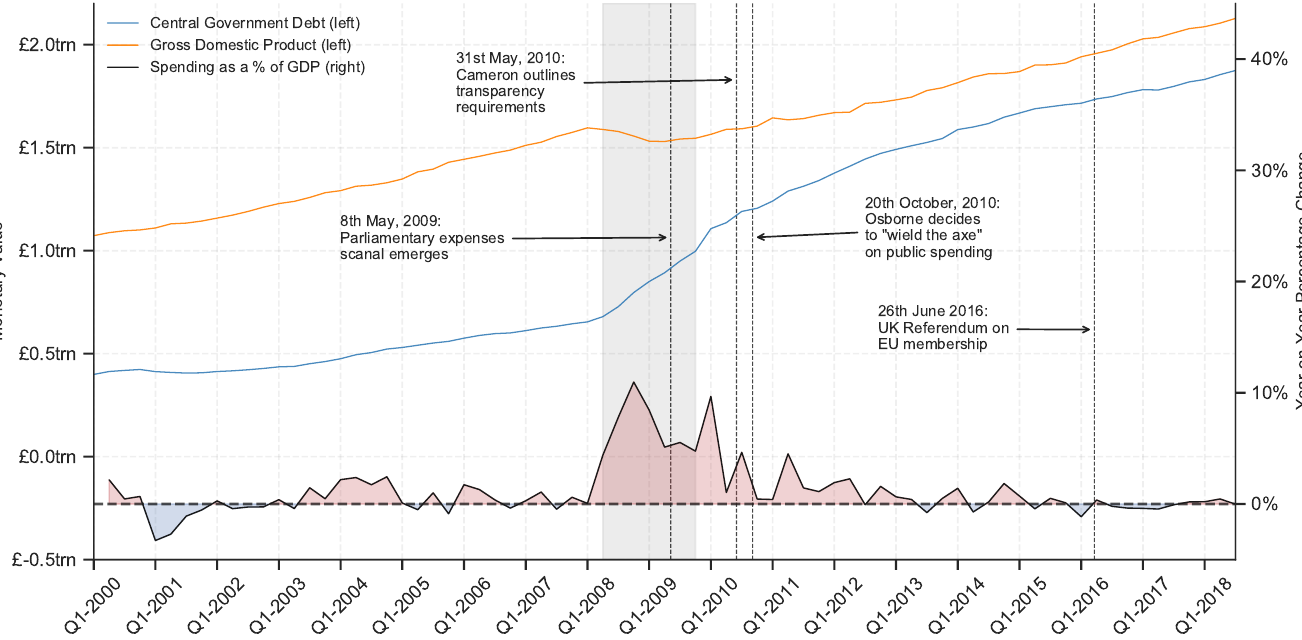
Figure 1: Central government debt and Gross Domestic Product in the United